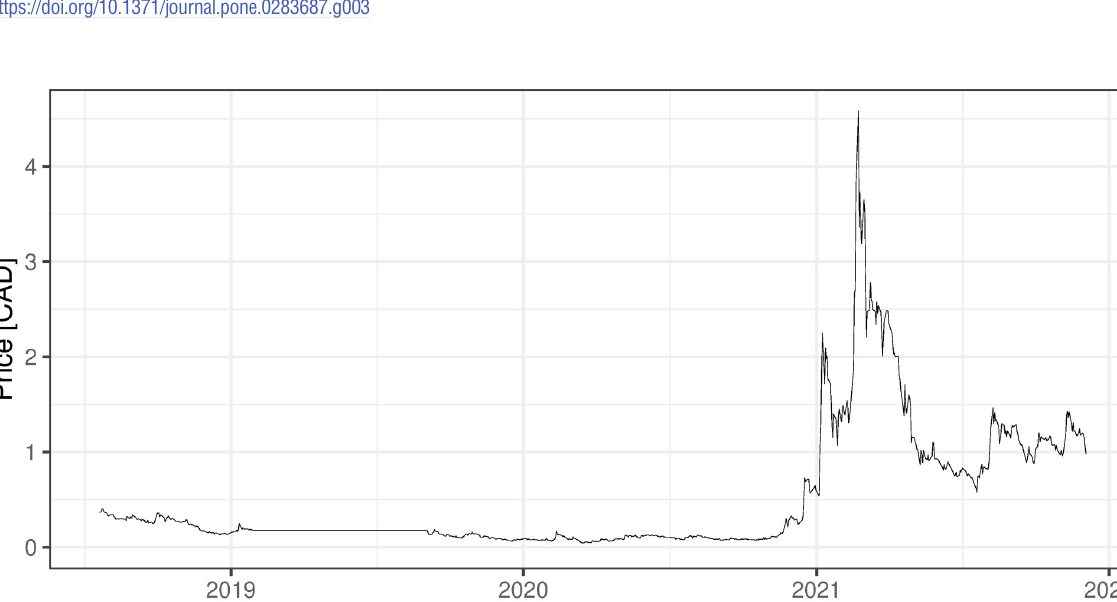
iii. DMG Blockchain (TSXV:DMGI). The company is traded on Toronto Stock Exchange. The